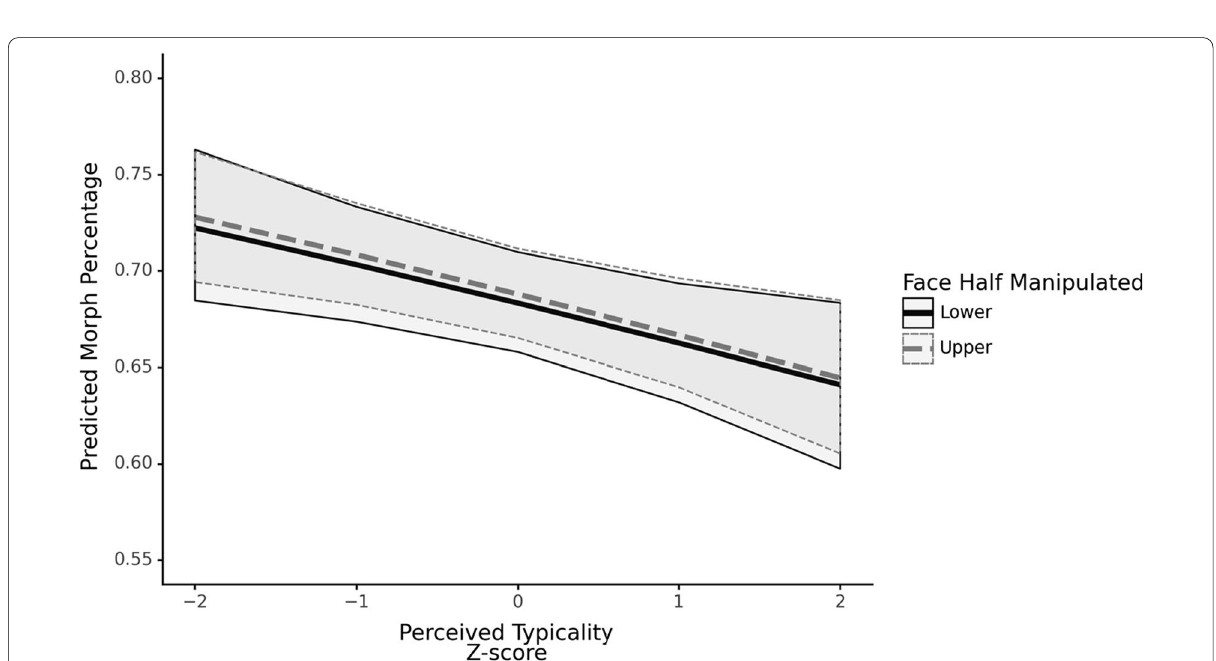
Fig. 6 Predictions of both models for varying levels of perceived typicality, holding measured typicality constant. Bands represent the Bayesian 95% credible